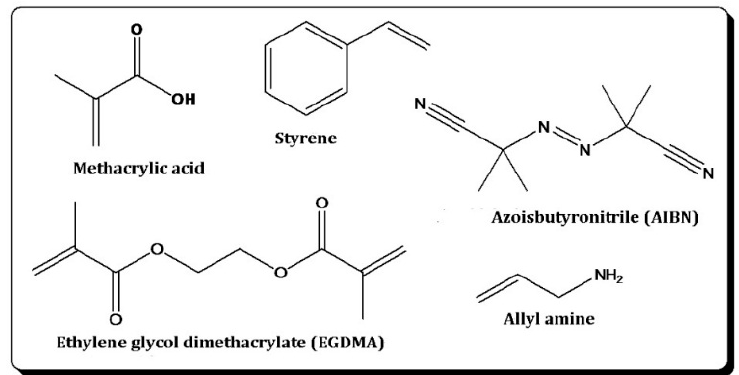
Figure 1. Monomers and reagents used.